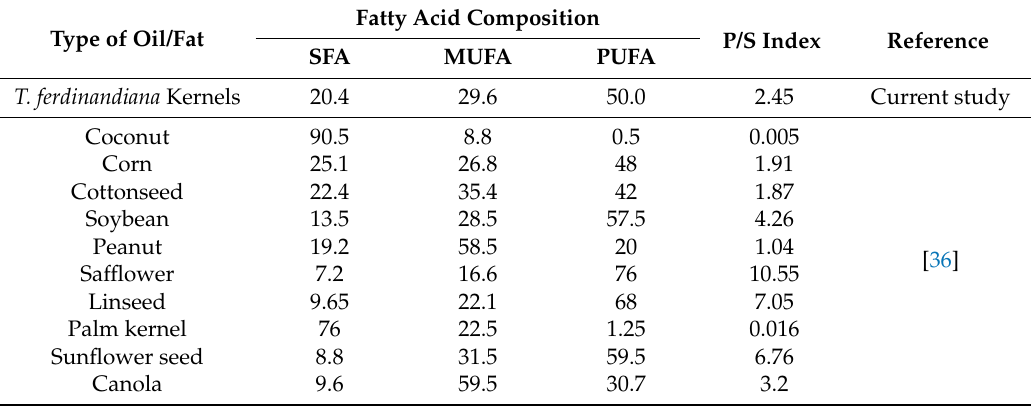
Table 5. Comparison of the fatty acid compositions of Terminalia ferdinandiana kernels with commonly consumed oils and